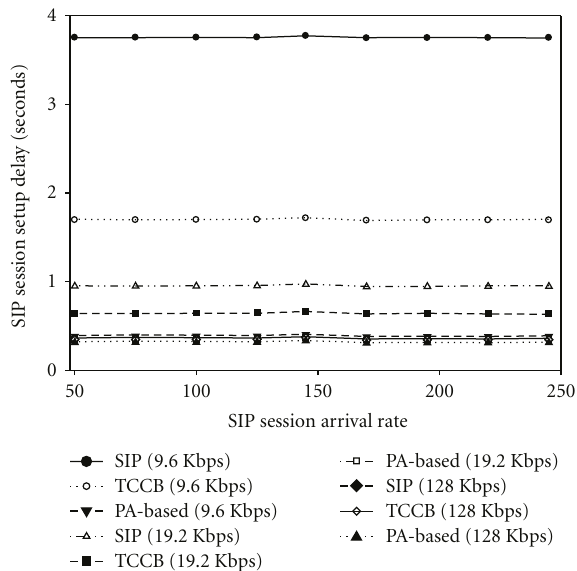
Figure 7: SIP session re-setup delay for di ff erent radio